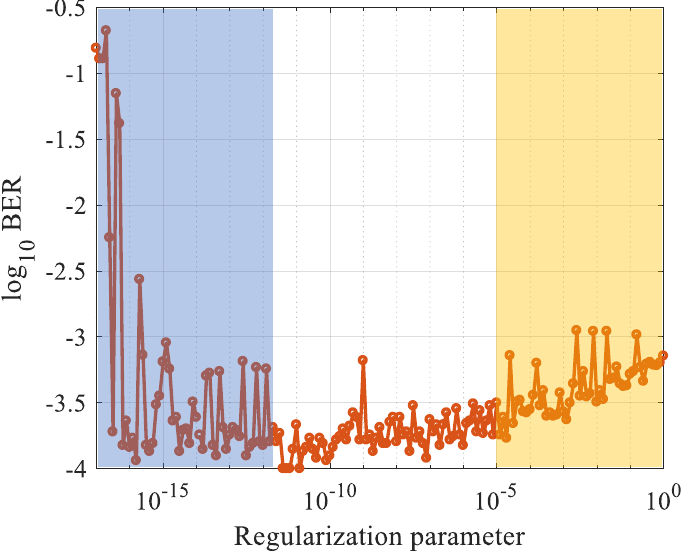
Figure 8. Relationship between regularization parameter reg and BER.